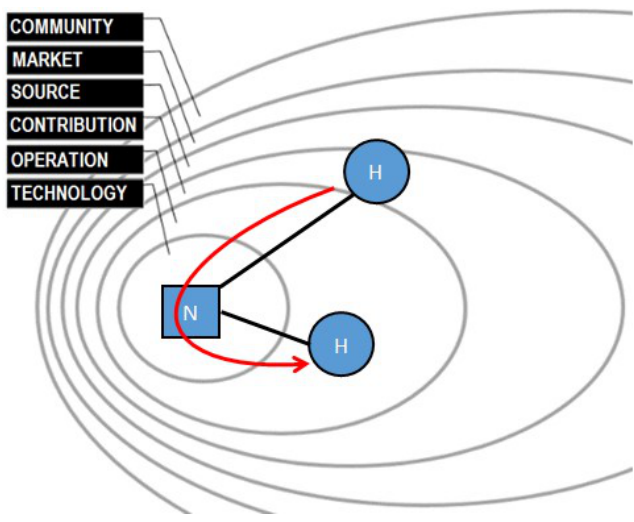
Fig. 21. Actors taking advantage of the system as a path to influence